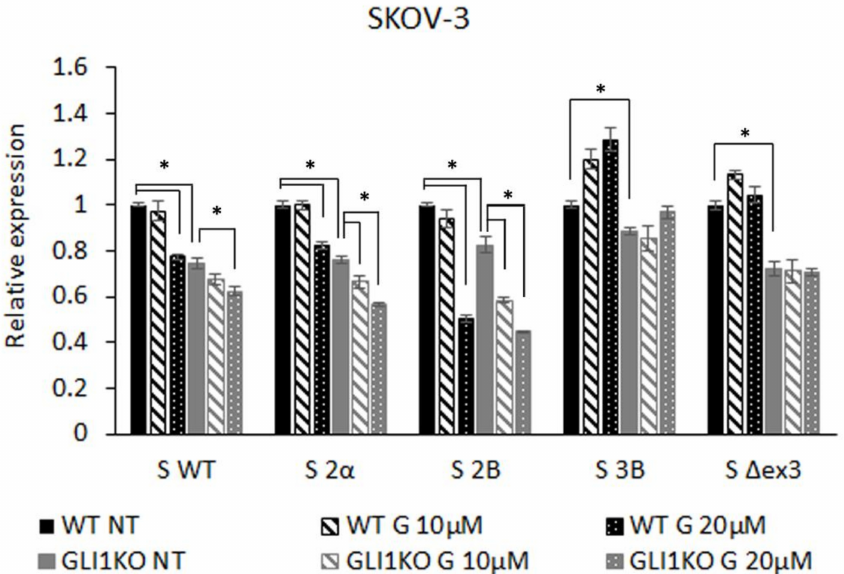
Figure 3. Survivin isoform expression levels in the SKOV-3 WT cell line and the SKOV-3 GLI1 KO cell line after treatment with the GLI1/2 inhibitor GANT-61 for 24h. NT, non-treated samples; G 10 µ M, cells treated with 10 µ M GANT-61; G 20 µ M, cells treated with 20 µ M GANT-61. * represents statistically significant downregulation ( p < 0.05).